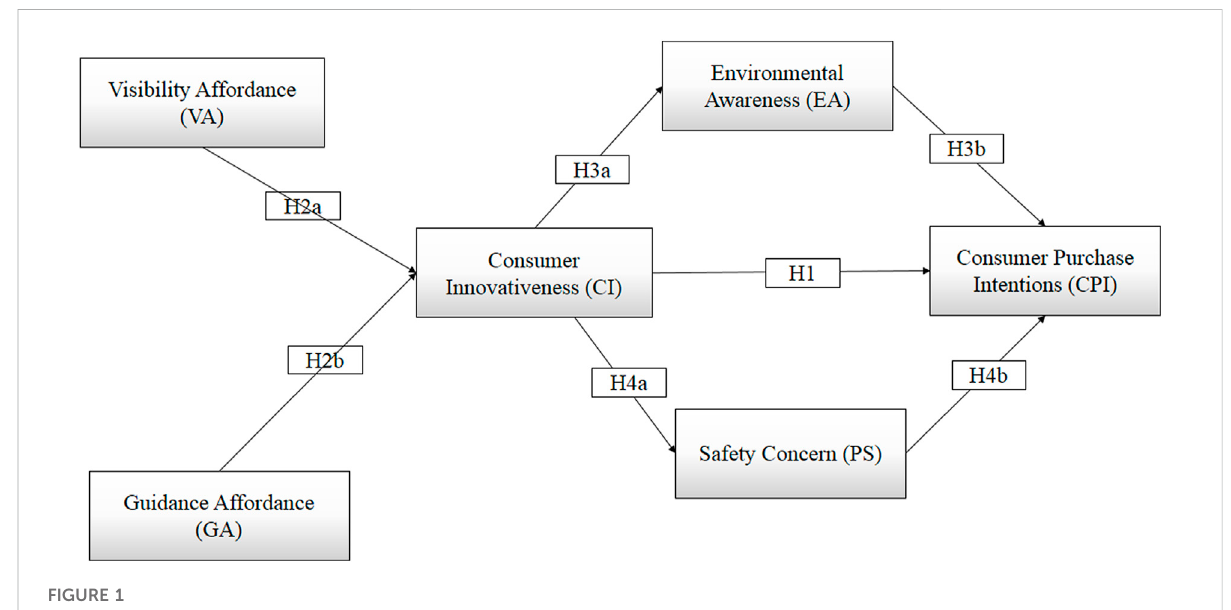
FIGURE 1 Proposed